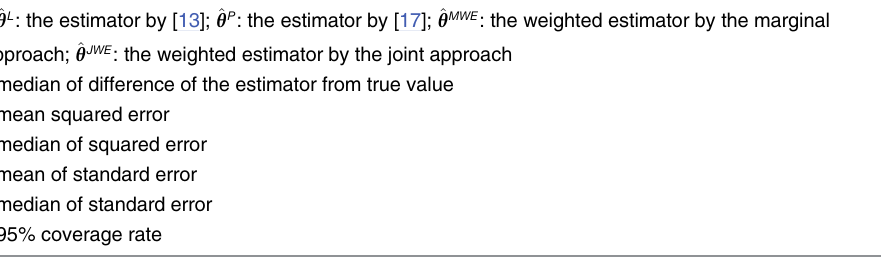
1 ^ θ L : the estimator by [13]; ^ θ P : the estimator by [17]; ^ θ MWE : the weighted estimator by the marginal approach; ^ θ JWE : the weighted estimator by the joint approach 2 median of difference of the estimator from true value 3 mean squared error 4 median of squared